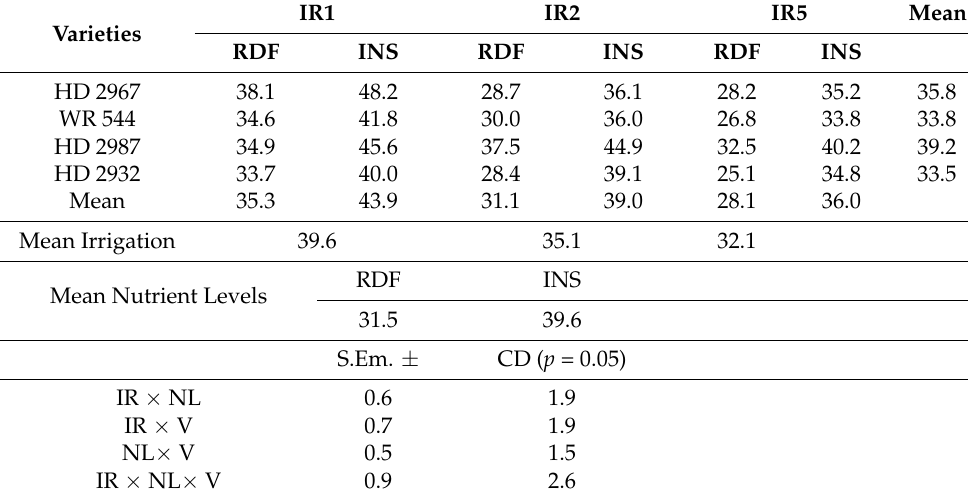
Table 6. Interaction effect of nutrient management levels, irrigation schedules, and varieties on acid phosphates ( µ g PNP/g